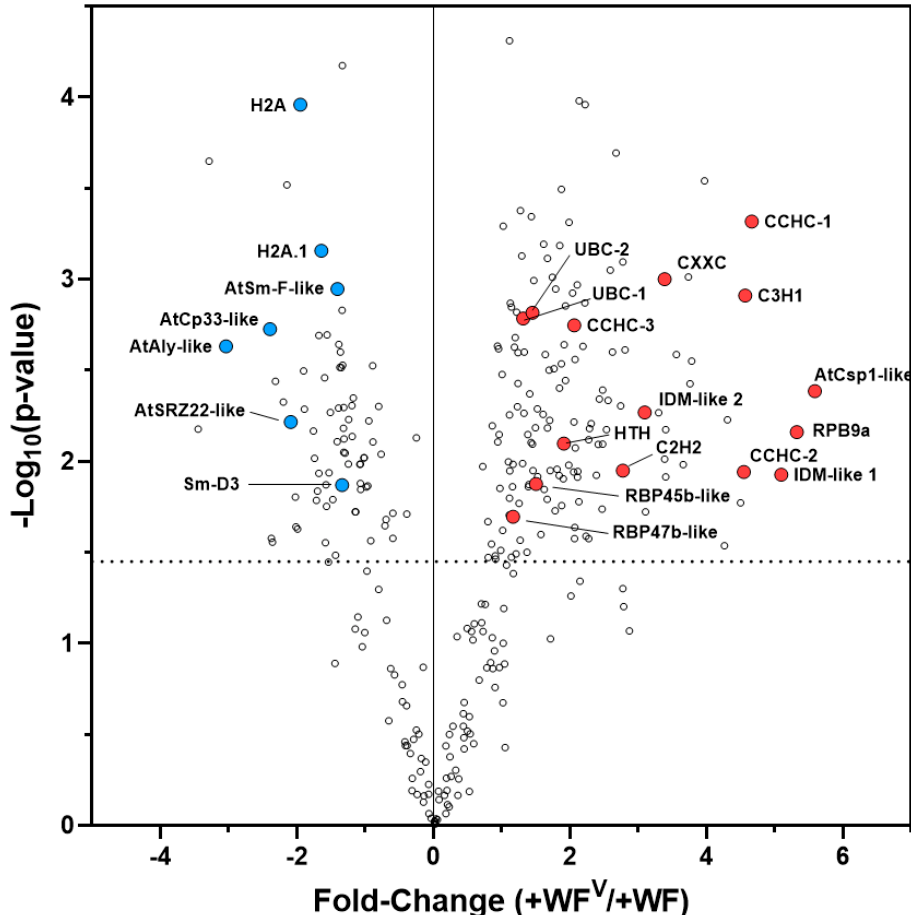
Figure 4. Volcano plot of pairwise + WF and + WF V comparison from systemic leaves at 10 dpf identified multiple proteins whose abundance changed significantly as a specific response to tomato mottle virus (ToMoV) (B-H q -value < 0.05). AtCsp1-like, Solyc03g033500; RBP9a, Solyc05g053430; IDM-like 1, Solyc01g098810; CCHC-1, Solyc02g083800; C3H1, Solyc11g008900; CCHC-2, Solyc10g055250; CXXC, Solyc11g070050; IDM-like 2, Solyc04g082720; C2H2, Solyc09g013120; CCH3, Solyc01g111275; RBP45-like, Solyc10g005260; UBC-1, Solyc01g007860; UBC-2, Solyc10g083120; RPB47b-like, Solyc10g050860; Sm-D3, Solyc03g033600; Sm-F-like, Solyc10g081370; H2A.1,